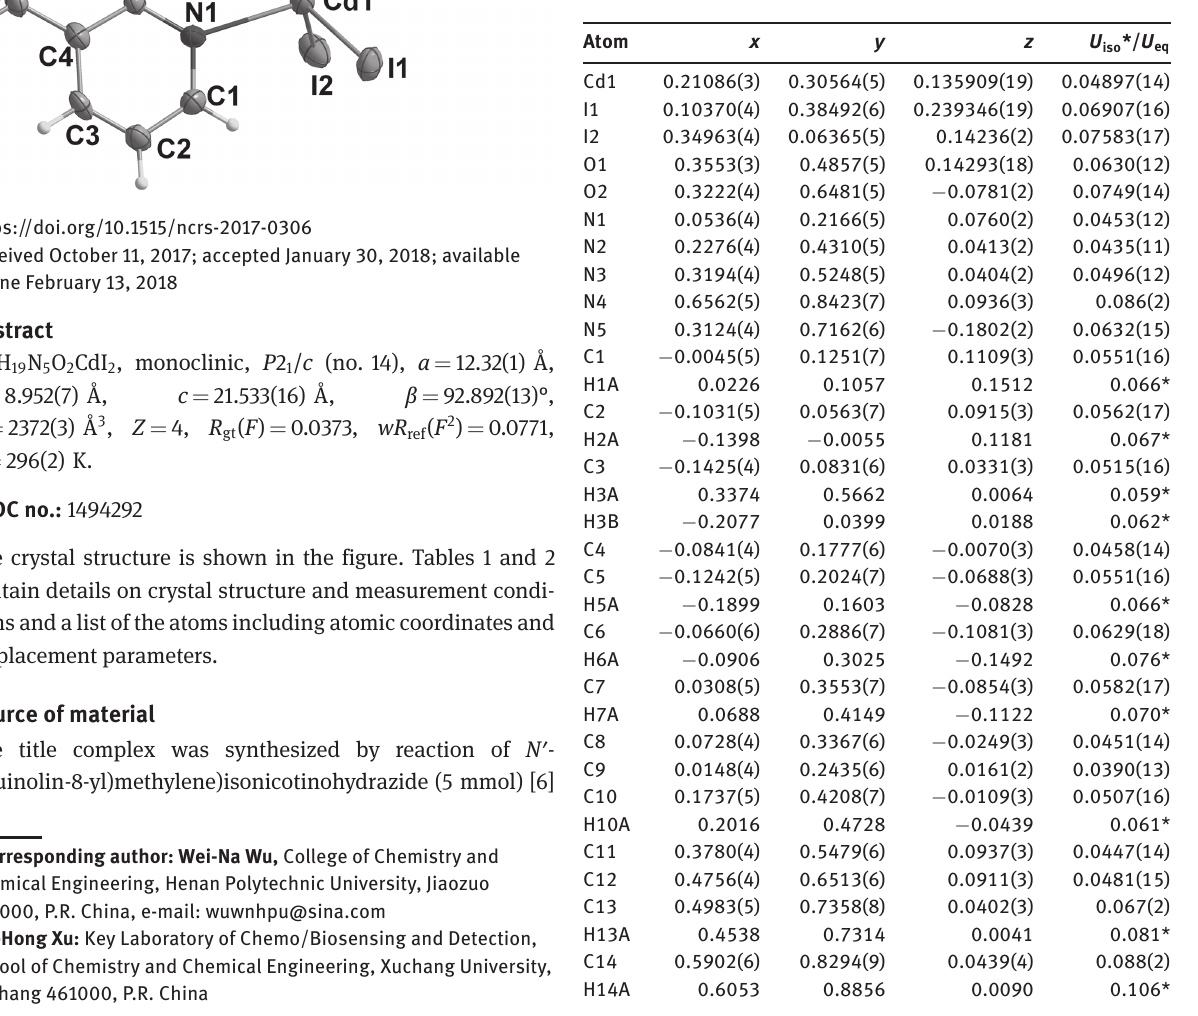
Table 2: Fractional atomic coordinates and isotropic or equivalent isotropic displacement parameters (Å 2